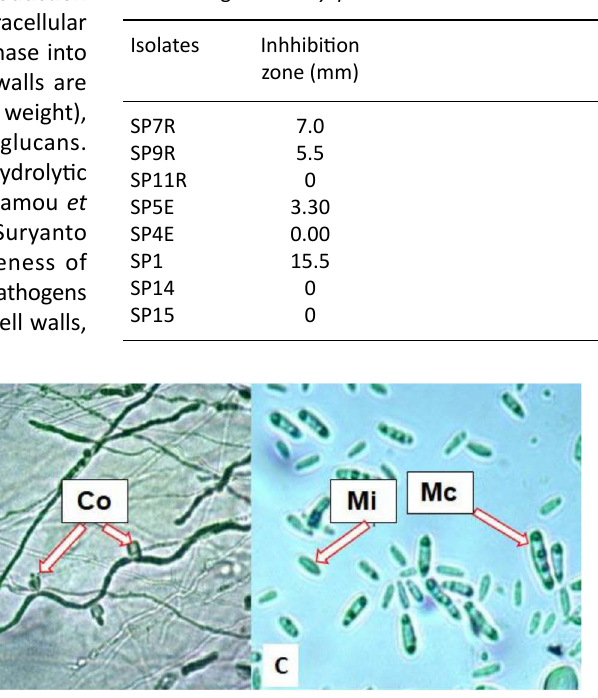
Fig. 1. F. oxysporum isolated from unhealthy chrysant. (A). Colony on PDA medium after 7 incubation days at 29°C, (B). Hypha with conidiospore (Co), (C). Microconidia (Mi) and Macroconidia (Ma)